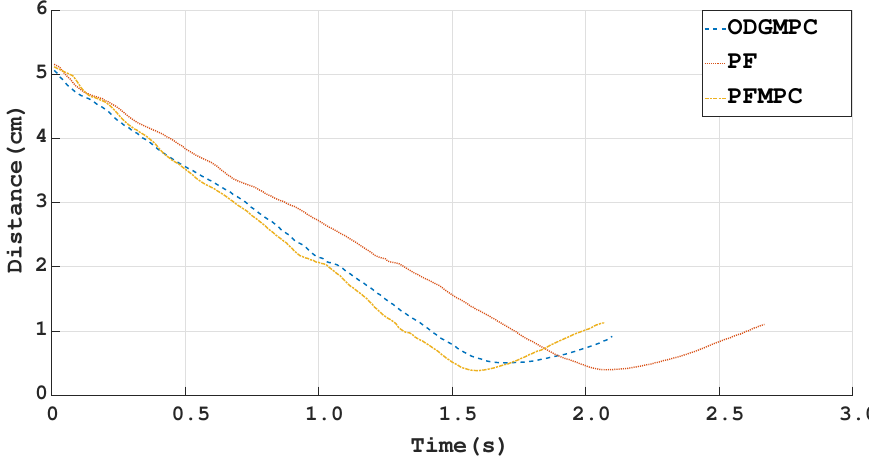
Figure 27. Results of the obstacle distance from Scenario 3 for static Obstacle 1.